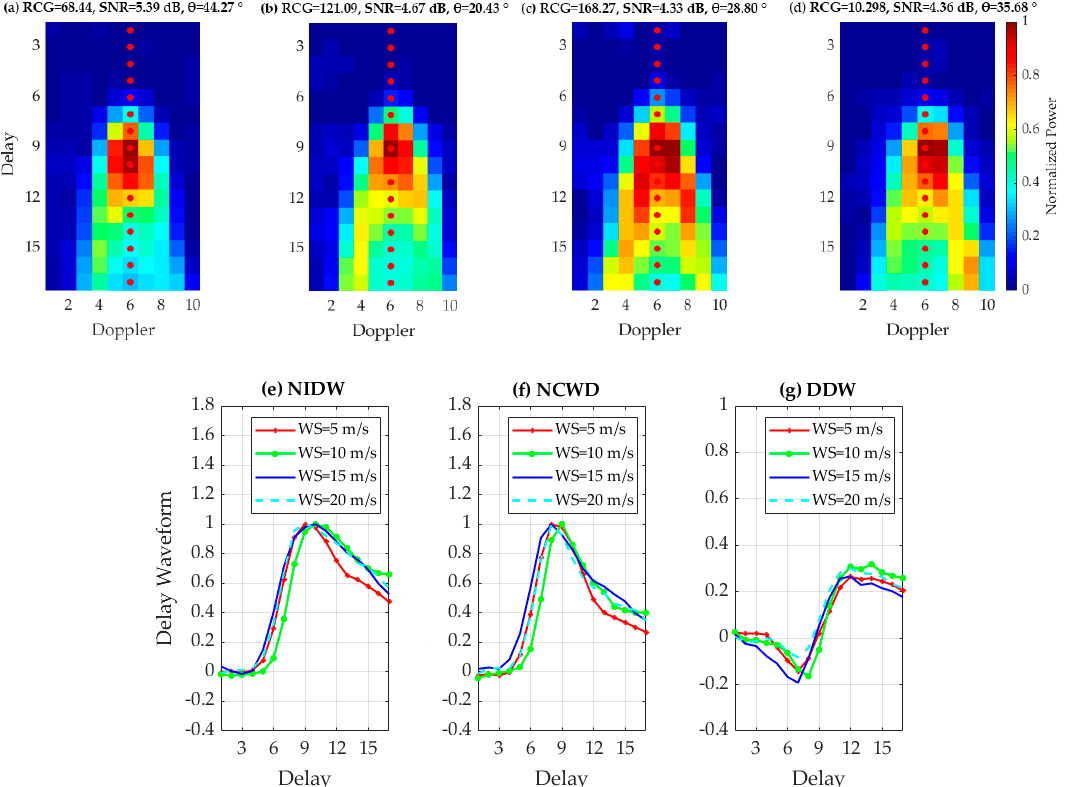
Figure 3. Delay-Doppler map (DDM) and its time delay waveform under different wind speed conditions. The DDM was obtained by the Delay Doppler Map Instrument (DDMI) on the CYGNSS satellites on 13 May 2020, with the day-of-year being 134. ( a ) The wind speed is about 5 m/s; ( b ) the wind speed is about 10 m/s; ( c ) the wind speed is about 15 m/s; ( d ) the wind speed is about 20 m/s. Range corrected gain (RCG), signal to noise ratio (SNR), and incidence angle ( θ ) are shown in this figure. The red dots represent normalized central delay waveform (NCDW) with Doppler = 0 Hz. The NIDW, NCDW, and DDW are compared in ( e – g ) at wind speeds of about 5, 10, 15, and 20 m/s, respectively.